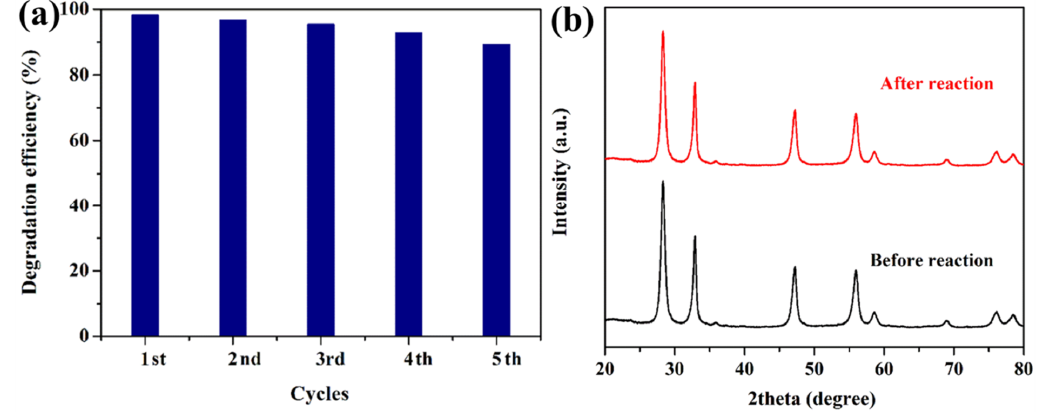
Figure 8. ( a ) Five recycling runs of CMS / BWO-2 for RhB removal; ( b ) the XRD patterns of the original and recycled CMS / BWO-2.